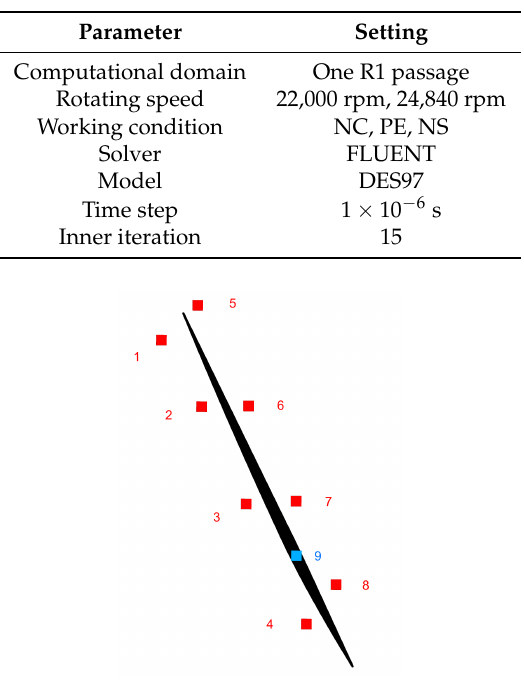
Figure 3. Monitor points in DES calculation (red: on casing, blue: on blade tip).